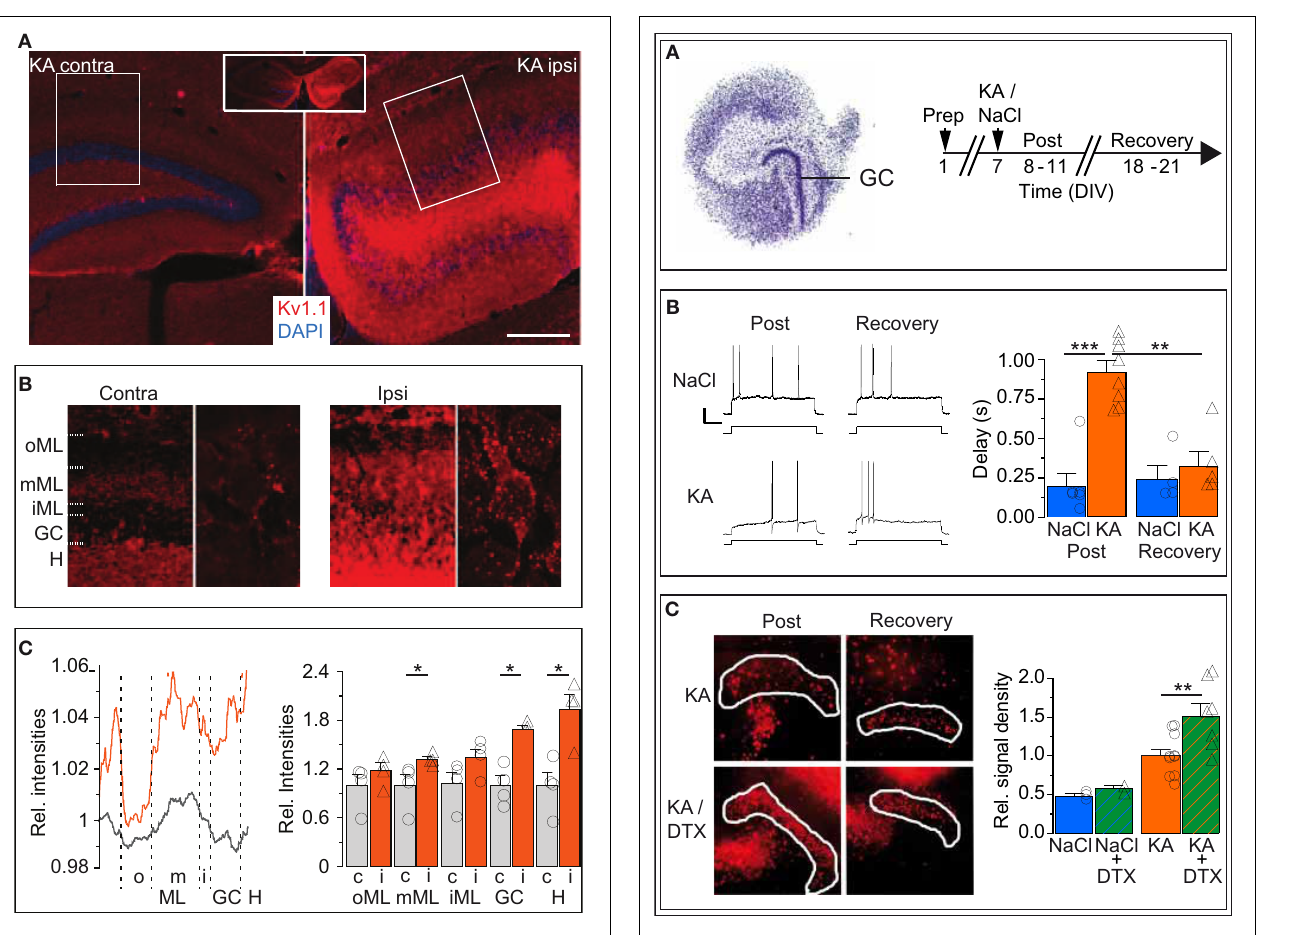
FIGURE 6 | In vitro KA model: Kv1.1 channel upregulation in DG cells is reversible and neuroprotective. (A) Organotypic hippocampal slice cultures (OHCs) prepared from P2 mouse pups were treated after 7 days in vitro (DIV) either with normal medium ( NaCl ) or with 15 μ M kainate ( KA ). Time-matched results were pooled into two periods: the acute post-KA (or post-NaCl) period (8–11DIV) and the recovery period (18–21DIV). (B) The AP response delays of cultured DG cells were strongly enhanced in KA vs. control slices during the acute period (compare upper and lower Post- traces, and blue Post-NaCl and orange Post-KA bars, respectively). Importantly, during the recovery period, the response delays of KA-incubated slices returned to small NaCl-like values (compare upper and lower Recovery traces and orange Post-KA and orange Recovery-KA bars, respectively). Scale bars , 20mV, 0.5s. Current steps: NaCl, 70pA; KA, 40pA. (C) Staining with propidium iodide (PI), a cell death marker, showed that KA induced widespread cell death of hippocampal cells ( left, Post-KA subpanel ), which was quantified in the DG cell layer ( white border , see Methods). The addition of Kv1 blocker DTX in the acute phase only mildly affected cell death under control conditions ( NaCl, NaCl/DTX ) but led to a massive increase in cell death in the DG cell layer ( left panel, Post-KA/DTX subpanel, and right panel ). These results indicate that the presence of functional Kv1 channels has a neuroprotective effect for DG